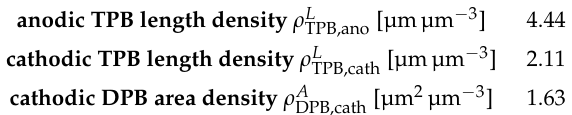
Table 7. Effective phase boundaries’